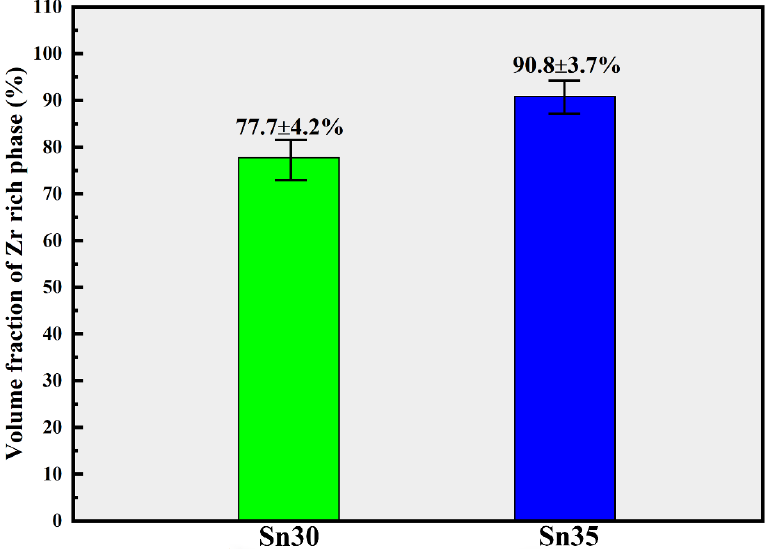
Figure 11. Volume fraction of Zr-rich phase in Sn30 BHEA and Sn35 BHEA.